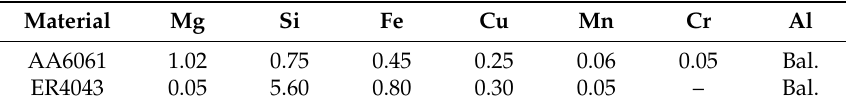
Table 1. Chemical compositions of AA6061 and ER4043 (wt%)